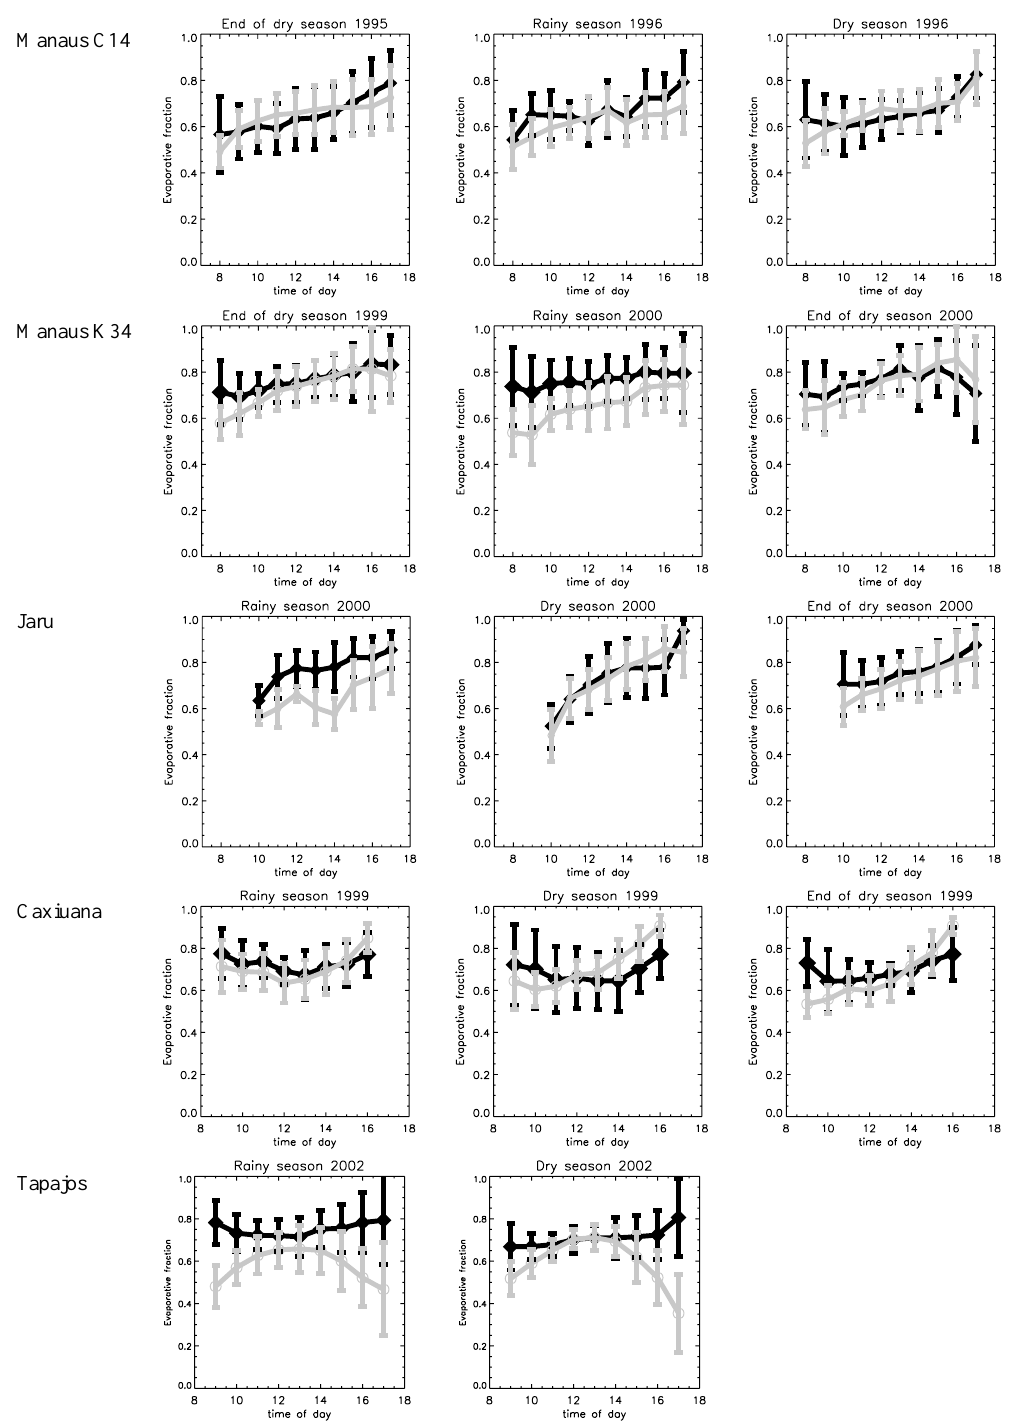
Fig. 4. Mean diurnal cycle of observed (black) and simulated (grey) evaporative